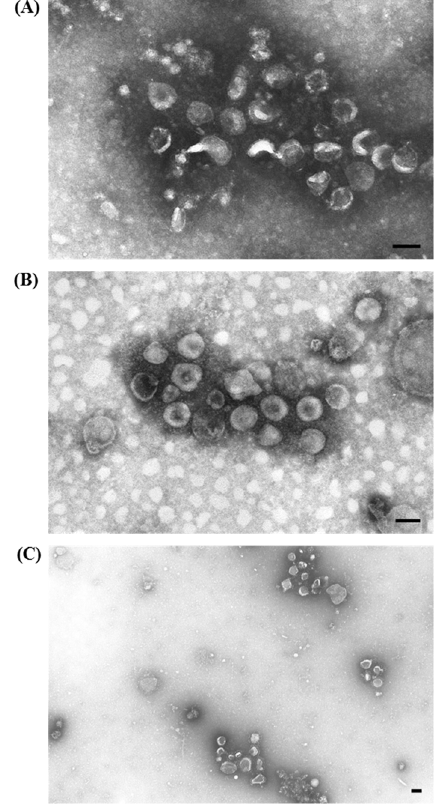
Figure 4. Electron micrographs of ultracentrifuged fecal contents from pigs with diarrhea from two distinct outbreaks ( A , B ). Coronavirus particles attributed to Porcine Epidemic Diarrhea virus (PEDV) are visible as aggregates. In both cases the particles are showing an external surface with spikes still visible but immersed in a halo of antibodies; ( C ) IAEM negative control: small groups of coronavirus particles with well–conserved surface spikes are